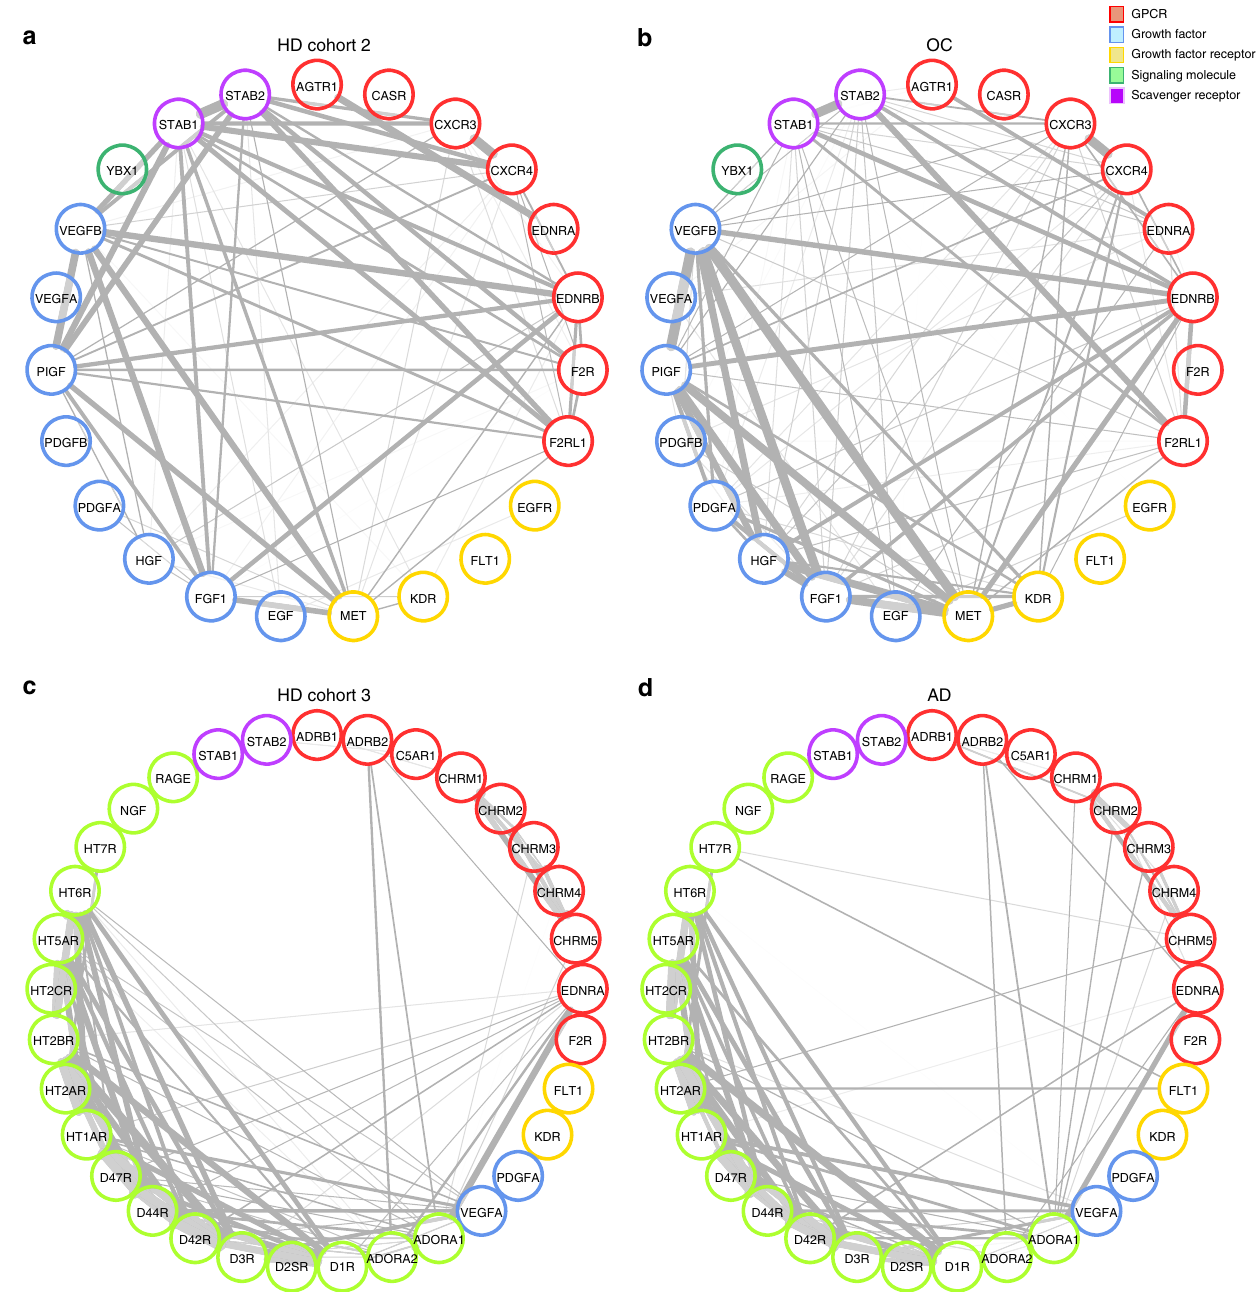
Fig. 3 Effects of ovarian cancer and Alzheimer ’ s disease on autoantibody correlations. Graphics display the comparisons of a healthy donors (HD) and patients with b ovarian cancer (OC; Supplementary Table 1, cohort 2; Supplementary Table 2, aab dataset 2) and c HD and patients with d Alzheimer ’ s disease (AD; Supplementary Table 1, cohort 3; Supplementary Table 2, aab dataset 3). The nodes in the graphs represent variables (each aab), and a line between two nodes indicates the Spearman ’ s rank correlation coef fi cient. The line width indicates the strength of the association, with stronger correlations indicated by thicker lines. Only correlations >0.6 are shown. Multiple connections of nodes indicate